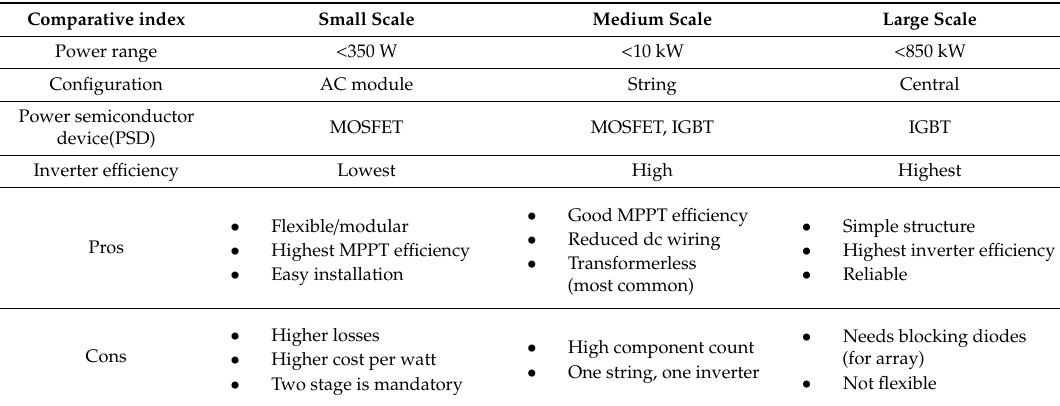
Table 5. PV grid inverter configurations—An Overview.